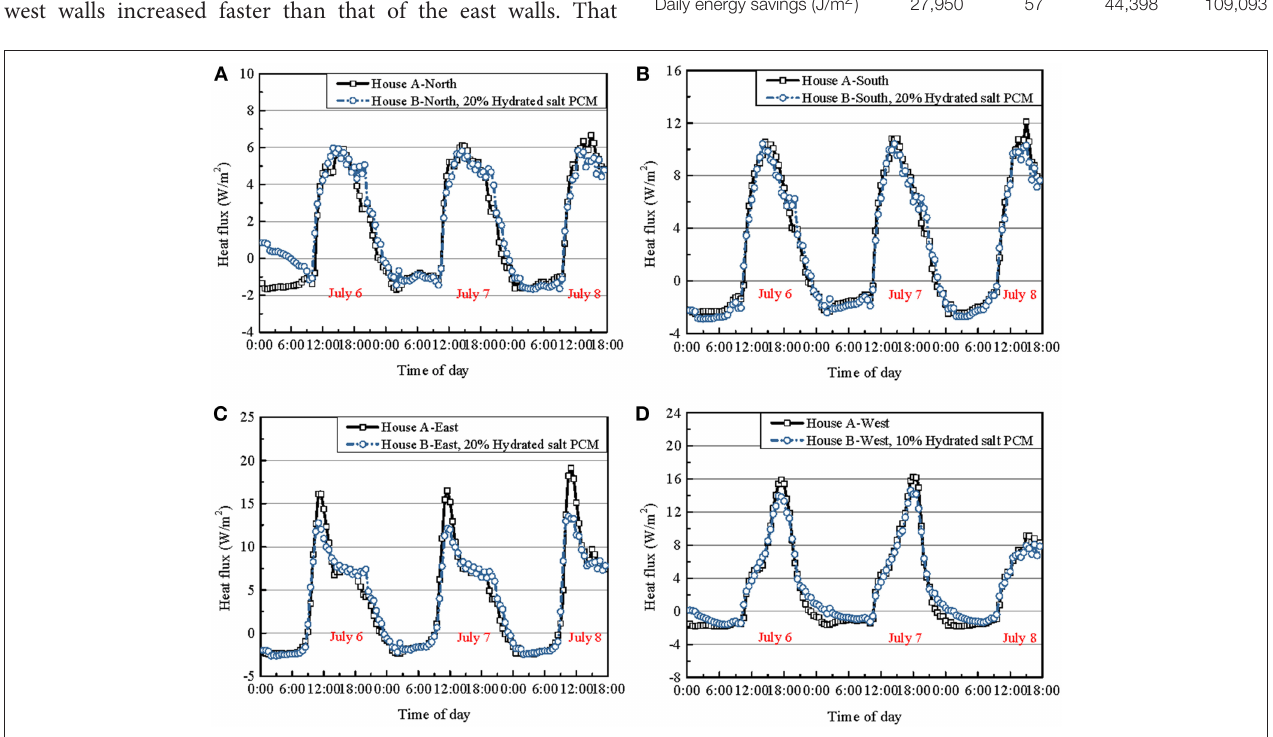
FIGURE 6 | Heat flux through exterior frame walls with 20 wt% PCM. (A) North-facing walls. (B) South-facing walls. (C) East-facing walls. (D) West-facing walls.